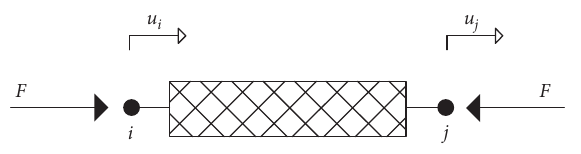
Figure 1: Outline of an inerter device.